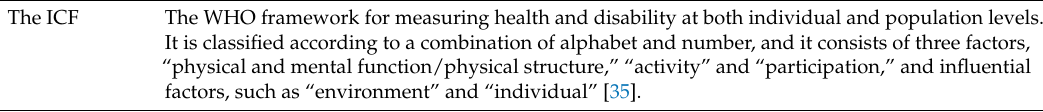
Table A2. The characterization of each evaluation